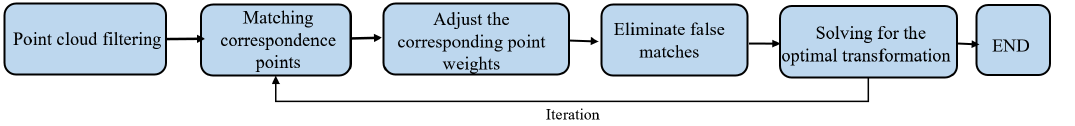
Figure 2. Flow of ICP.